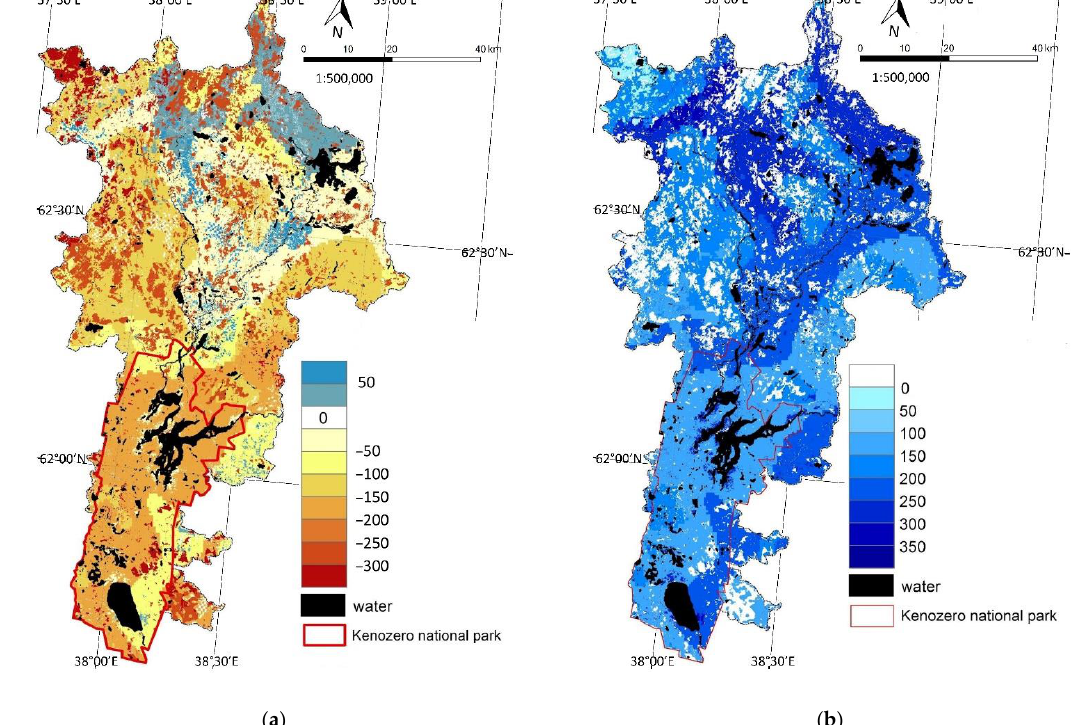
Figure 3. ES of water yield regulation: ( a ) annual runoff in 2007 (mm/year); ( b ) runoff change due to evapotranspiration by vegetation (mm/year).